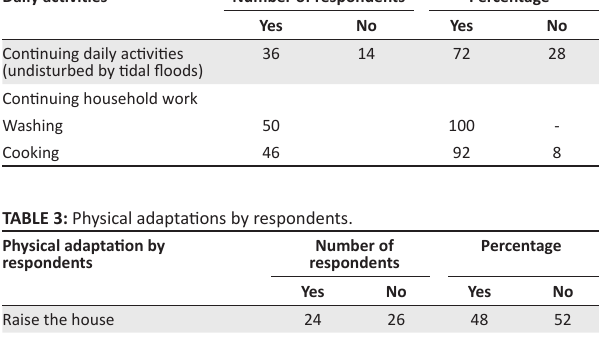
TABLE 2: The impact of tidal floods on community activities. Daily activities